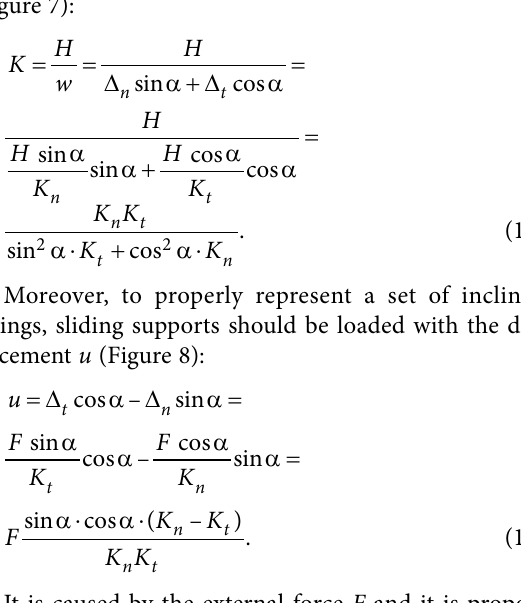
Figure 8. Calculation scheme of the displacement load